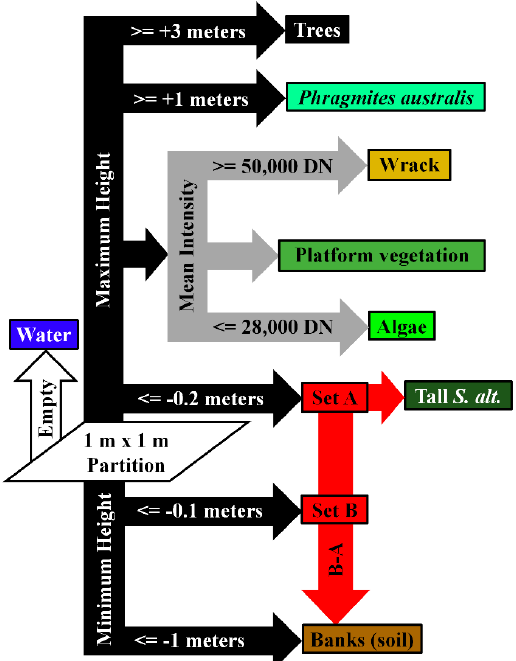
Figure 3. Airborne lidar saltmarsh classification method. Lidar data are divided into 1 m by 1 m partitions, then classified based on thresholds, rules and set-based operations to produce a final